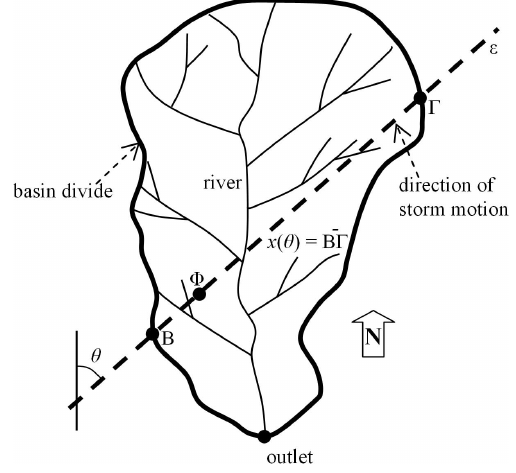
Fig. 10. Schematic illustration of the variables in Eq. (13), for a storm moving over a catchment at direction θ ; see main text for